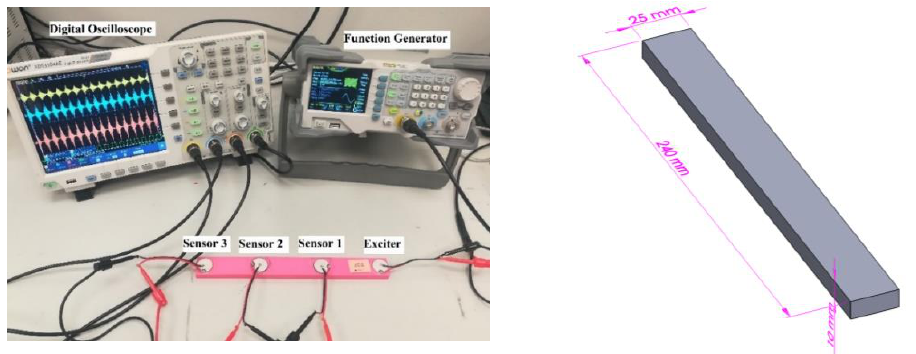
Figure 2. Experimental setup ( left ), and geometry of test specimens ( right ).